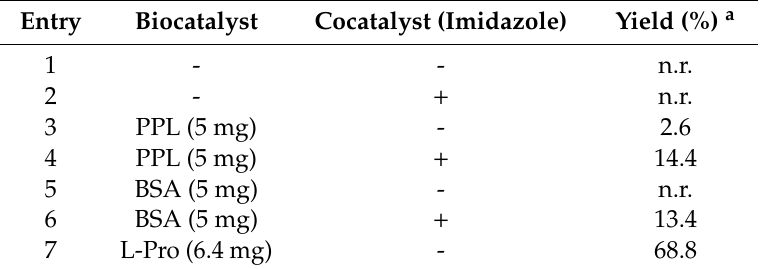
Table 2. Addition of imidazole as cocatalyst for reaction